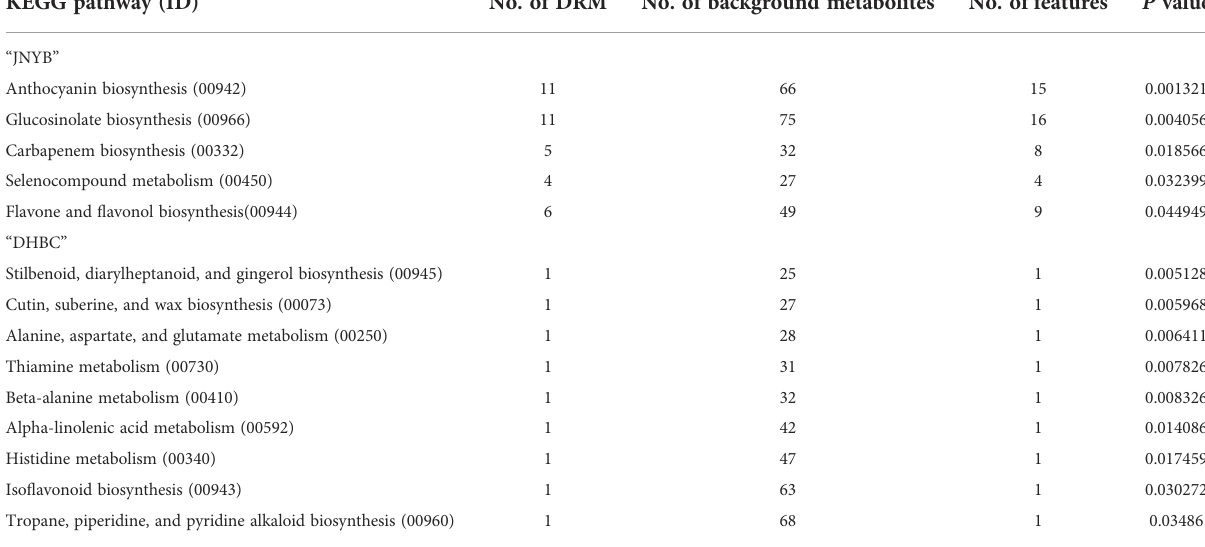
TABLE 2 KEGG pathways of “ JNYB ” and “ DHBC ” signi fi cantly regulated in response to clubroot. KEGG pathway (ID)